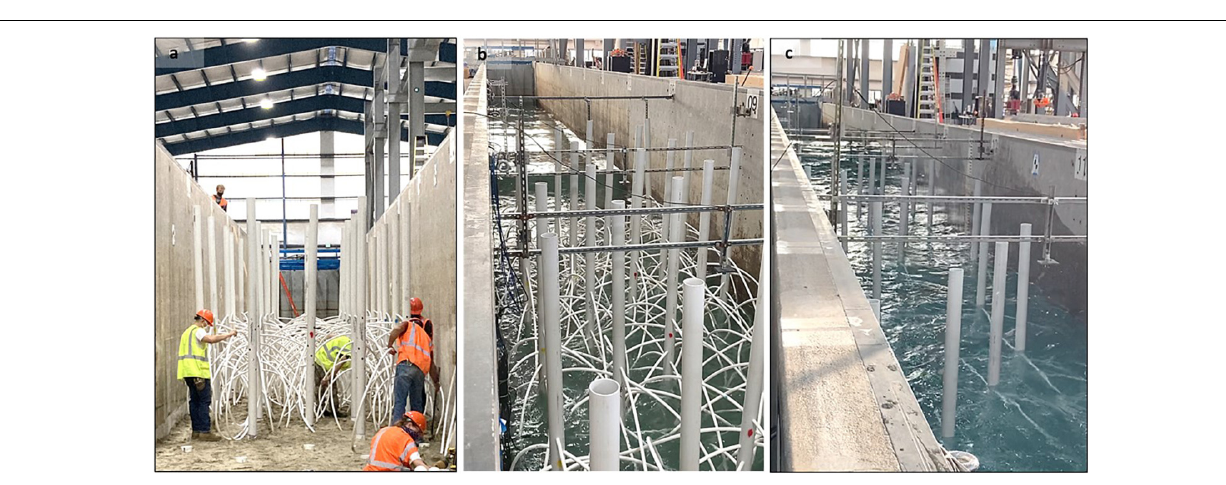
FIGURE 4 | (a) Construction of the model mangrove test section, high-density (HD) configuration; view toward wavemaker with (b) high-density (HD) mangrove configuration,